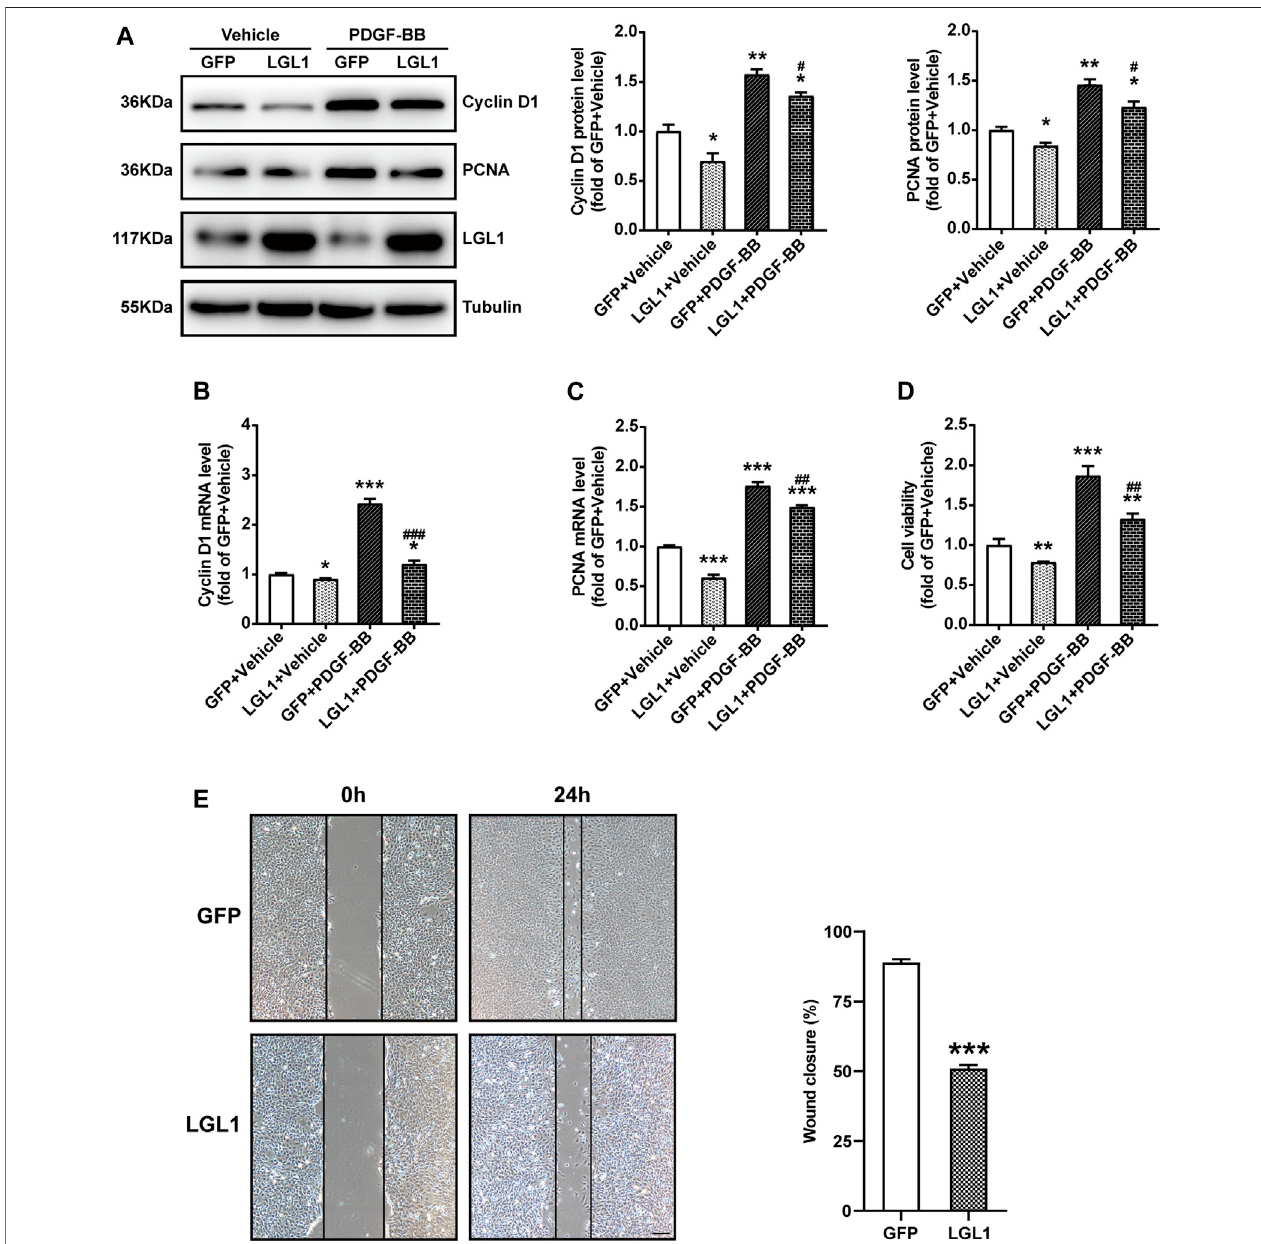
FIGURE 2 | LGL1 overexpression inhibited the proliferation and migration of VSMCs. (A) VSMCs were infected with adenovirus-expressing GFP or LGL1, then treated withPDGF-BB (20 ng/ml) for 48 h. The protein levels ofCyclin D1 and PCNA were detected by western blot ( n = 3). * p < 0.05, ** p < 0.01 vs. GFP + Vehicle. # p < 0.05 vs. GFP+PDGF-BB. (B,C) ThemRNAlevelsofCyclinD1 (B) andPCNA (C) weretestedbyqRT-PCR( n =4).* p < 0.05,*** p < 0.001 vs. GFP+Vehicle. ## p < 0.01, ### p < 0.001 vs. GFP +PDGF-BB. (D) Cell proliferation measured by CCK-8assay ( n = 3). ** p < 0.01, *** p < 0.001 vs. GFP +Vehicle. ## p < 0.01 vs. GFP + PDGF- BB. (E) Cell migration evaluated by scratch wound healing assay ( n = 9). Wound closure (%) represented migrative ability. Scale bar: 200 μ m. *** p < 0.001 vs.